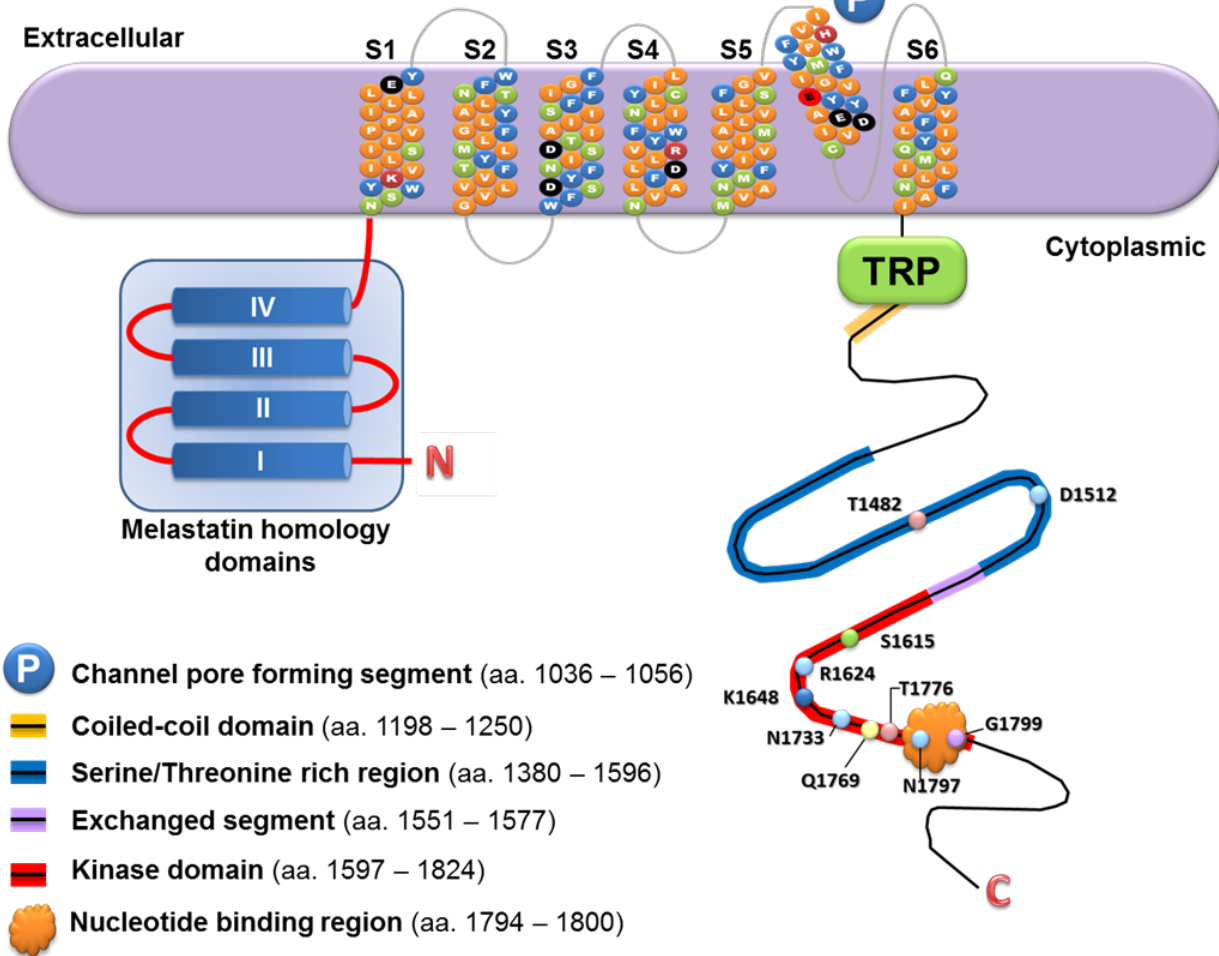
Figure 1. A schematic diagram to illustrate the protein structure of TRPM7 channel-kinase.